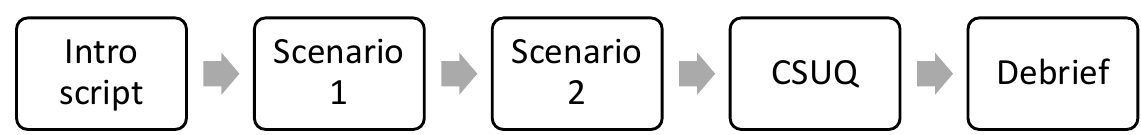
Figure 2. Chronological order of the simulation procedure completed by the healthcare providers during the 60-min usability session. CSUQ = Computer System Usability Questionnaire.